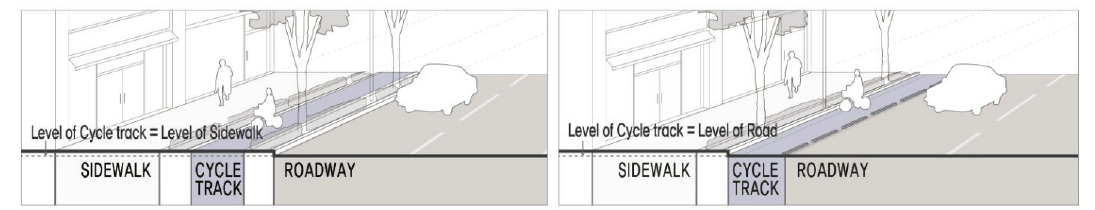
Figure 2. A raised cycle track (left) and A non-raised cycle track